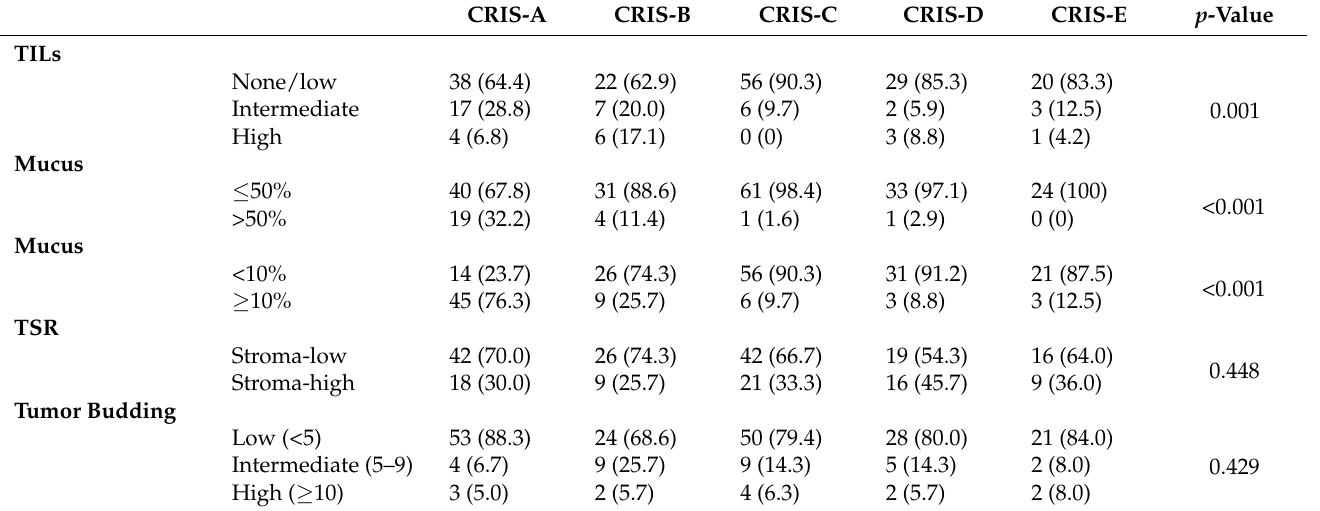
Table 3. Distribution of histopathologic features within the CRC intrinsic subtypes, shown as number and percentage. TILs = tumor infiltrating lymphocytes, TSR = tumor stroma ratio. p -values are derived from an overall comparison between